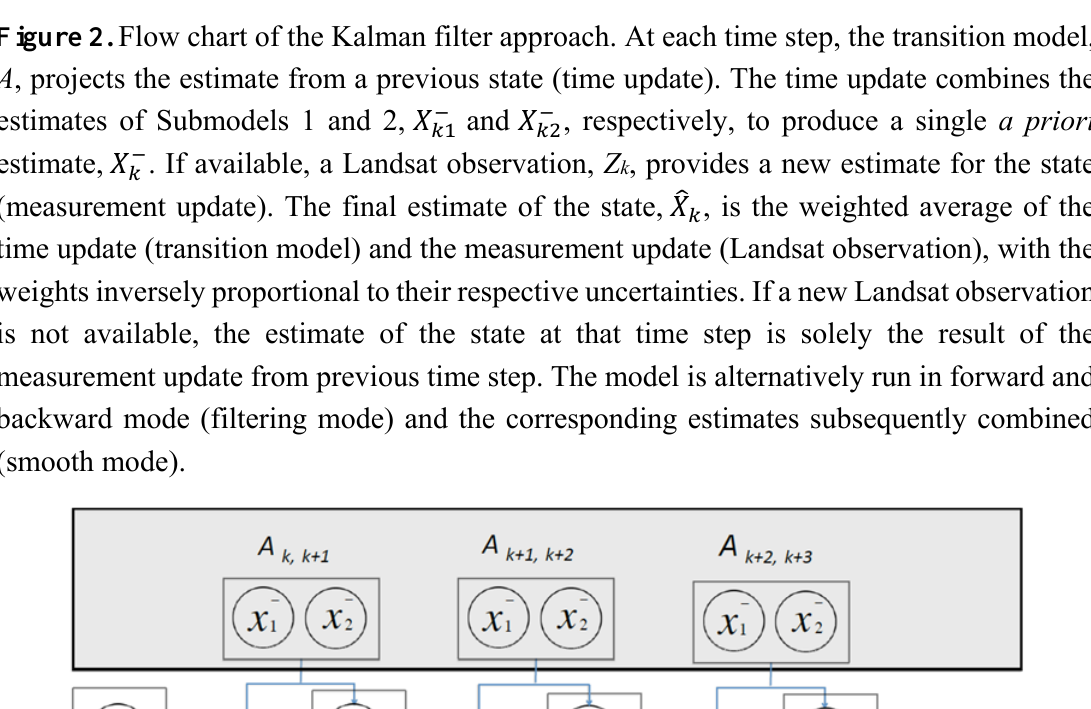
at the image level, respectively. In a reliable synthetic NDVI image, the prediction residuals should be